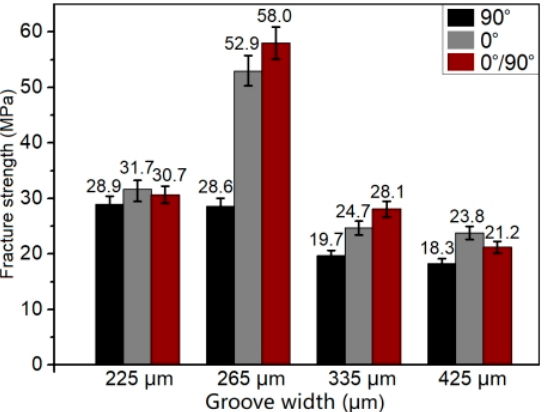
Figure 5. The fracture strength of the prepared CCF30/PEEK-Ti6Al4V joints with different textures on the Ti6Al4V surface.